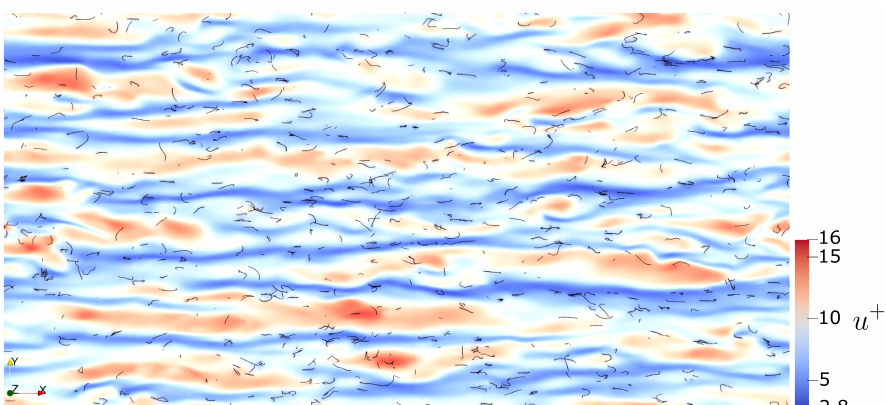
Figure 8. Top view of the streamwise fluid velocity streaks in the near-wall region ( z + = 10) and instantaneous fiber distribution. Reference simulation: St + n = 0.01, ρ p